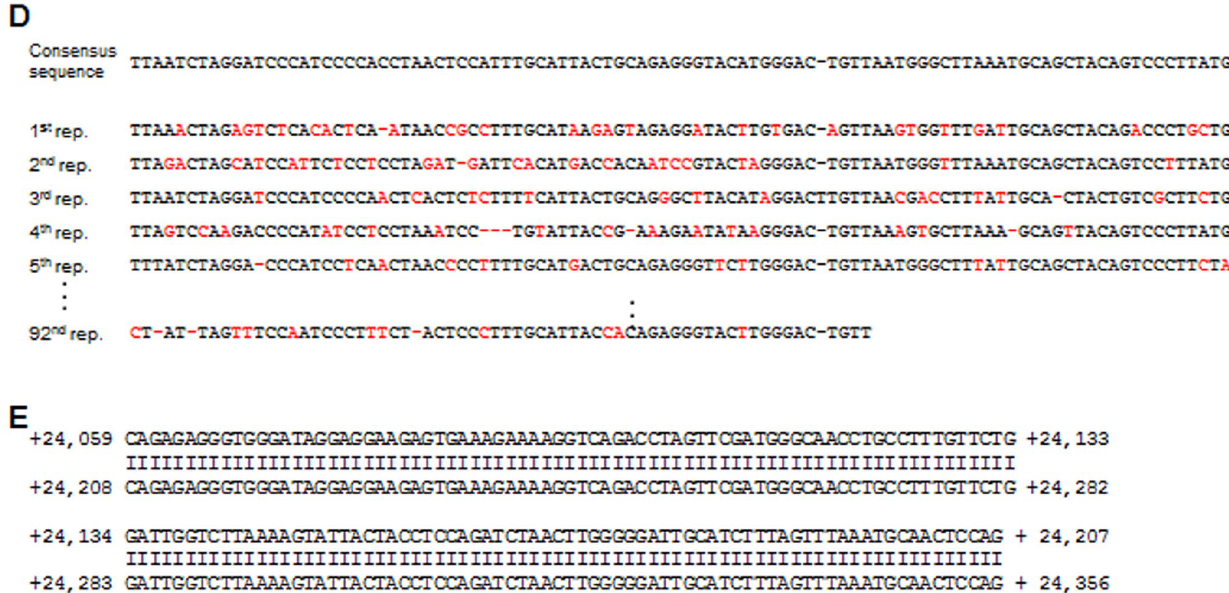
Figure 2. Analysis of repeat sequences in porcine XIST RNA. ( A) Distribution of repeated sequences in the porcine XIST gene model. Gray rectangles indicate exons, and the yellow boxes in the exons indicate repeat regions. The regions having homology with human, bovine, and mouse XIST/Xist are represented to red (h), green (b), and blue (m) boxes, respectively. The first and second repeat regions showed similarity with all accessed XIST/Xist sequence from other species (dashed lines). The diagram is scaled. (B) The first repeat region in porcine XIST . A monomer of the first repeat